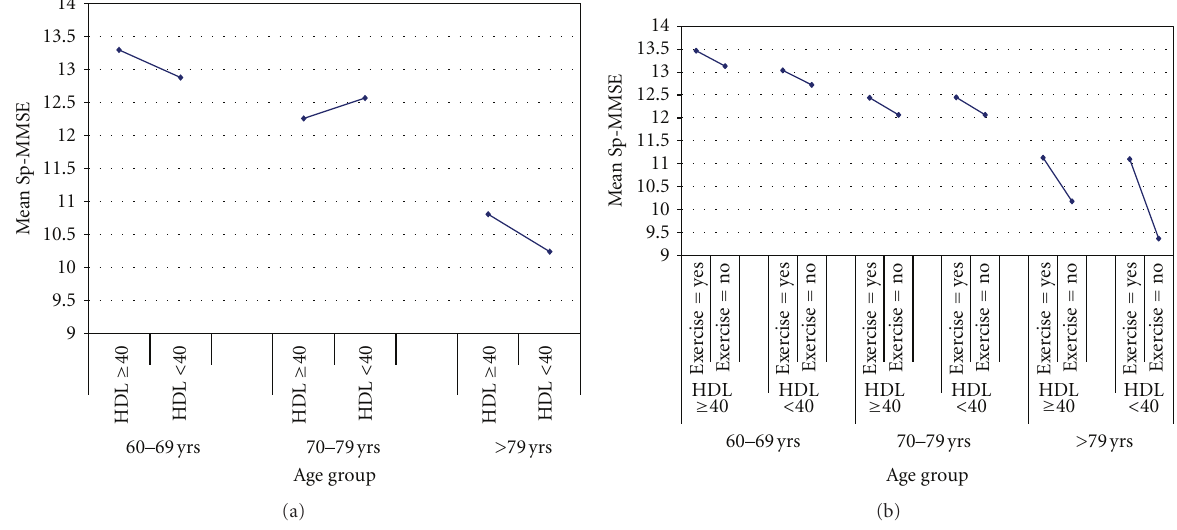
Figure 3: Adjusted mean short portable MMSE by HDL-C levels and aerobic exercise